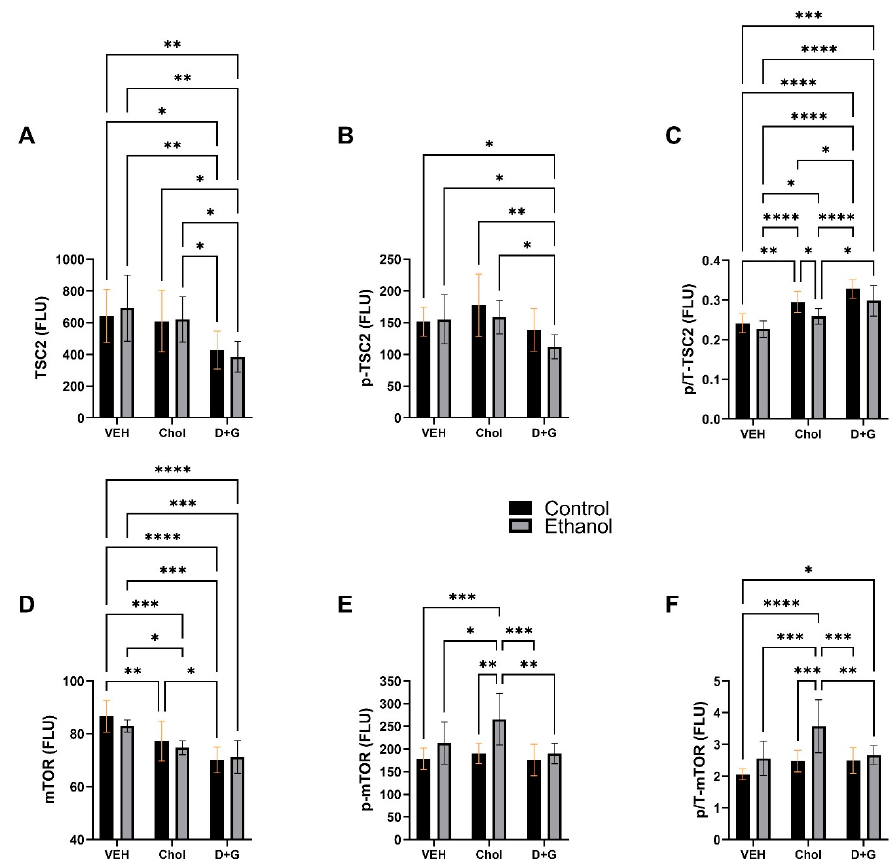
ethanol x treatment interactive effects on TSC2, mTOR, p70S6K, RPS6, pS939 -TSC2, pS2448 -mTOR, pT412 -p70S6K, and pS235/236 -RPS6, and the calculated relative phosphorylation levels (p/T). DF for all tests: interaction DFn, DFd (2, 30); treatment DFn, DFd (2, 30); exposure DFn, DFd (1, 30). The bold font highlights significant results. Bold italics highlight statistical trends. Abbreviations: R = receptor; p = phosphorylated; N.S. = not statistically significant. N = 6 rats/group with 3 replicate cultures per rat.